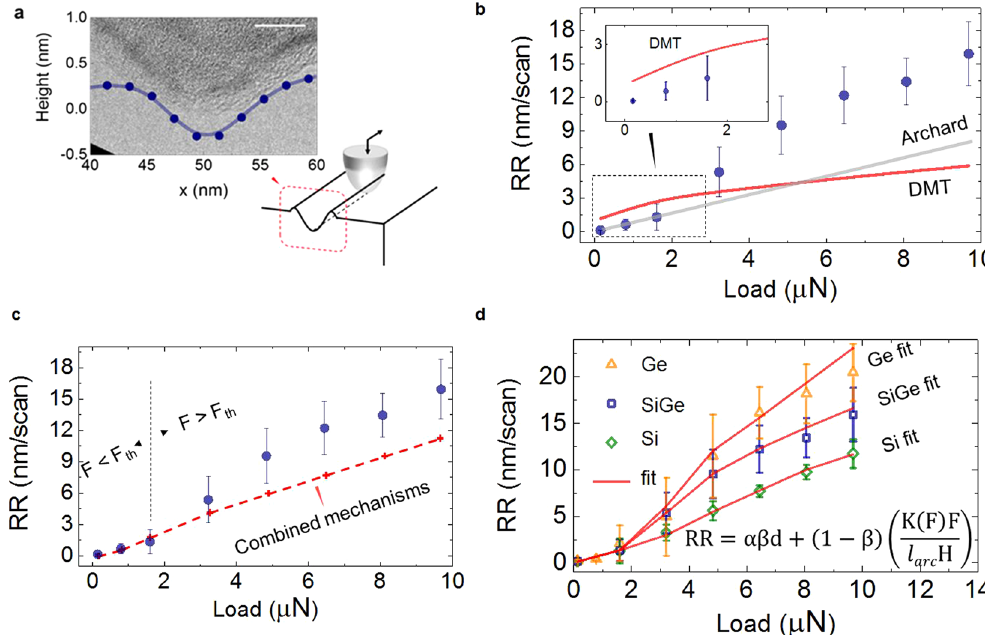
Figure 5. Modeling of the experimental RR. ( a ) Very good agreement is observed between the observed groove and the diamond tip, as shown by the over imposition of a 2D profile with a high resolution TEM image of the tip apex, scale bar 5 nm. ( b ) The RR of SiGe is plotted with the addition of the indentation depth as calculated with the DMT model and the Archard’s law equation derived by fitting the low-force regime. ( c ) In our model we propose to sum of the two contributions weighted by a coefficient ( β ) which is used to define the onset of the elastic-to-plastic transition and a coefficient ( α ) to account for the overlap between adjacent lines. This combination provides an improved approximation of our model with the experimental RR, however a certain underestimation of the high-force regime remains. ( d ) A complete version of our model requires also a